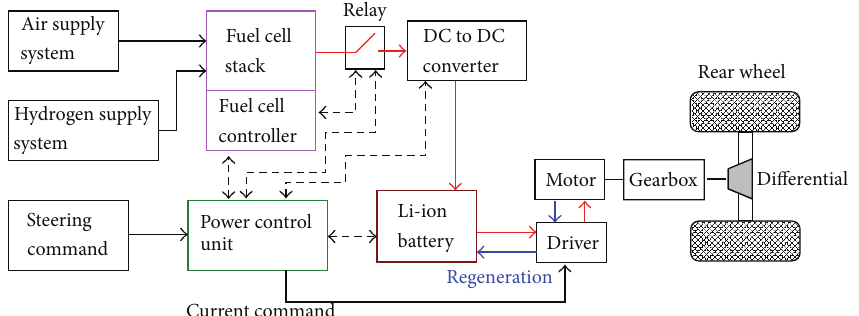
Figure 5: Schematics of presented FC-REEV system.